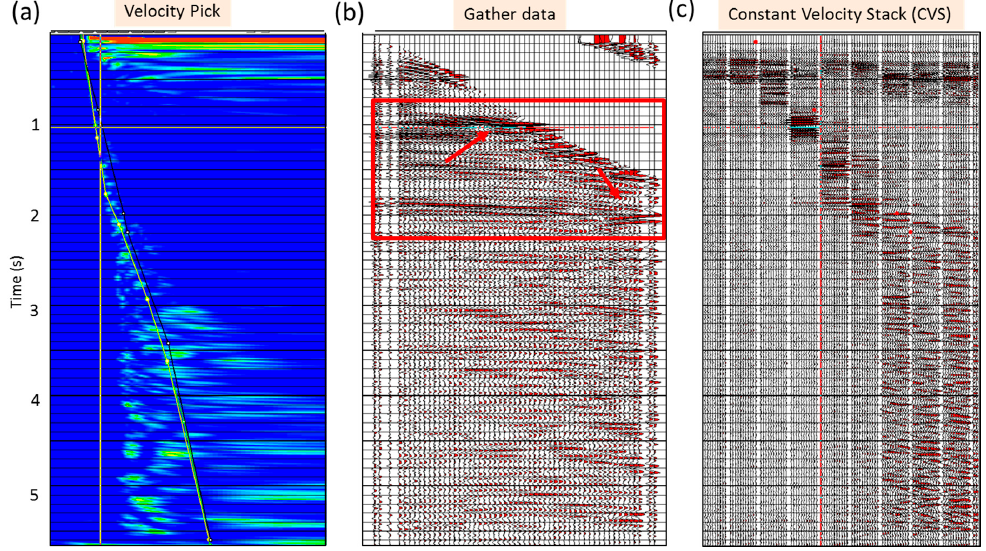
Figure 6. (a) The semblance velocity vs. time plot of the common mid-point (CMP) 1940, (b) absolute offset gather data after picking the velocity, and (c) constant velocity stack (CVS).